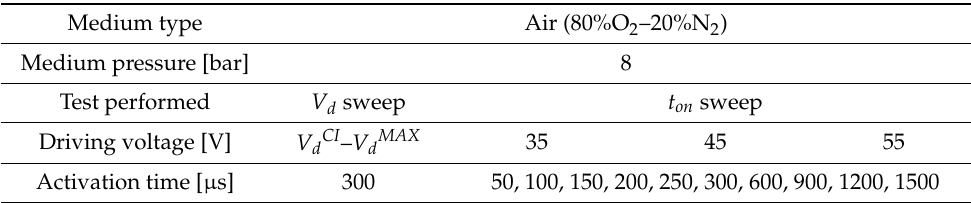
Table 2. Test Table 2 . Test campaign.